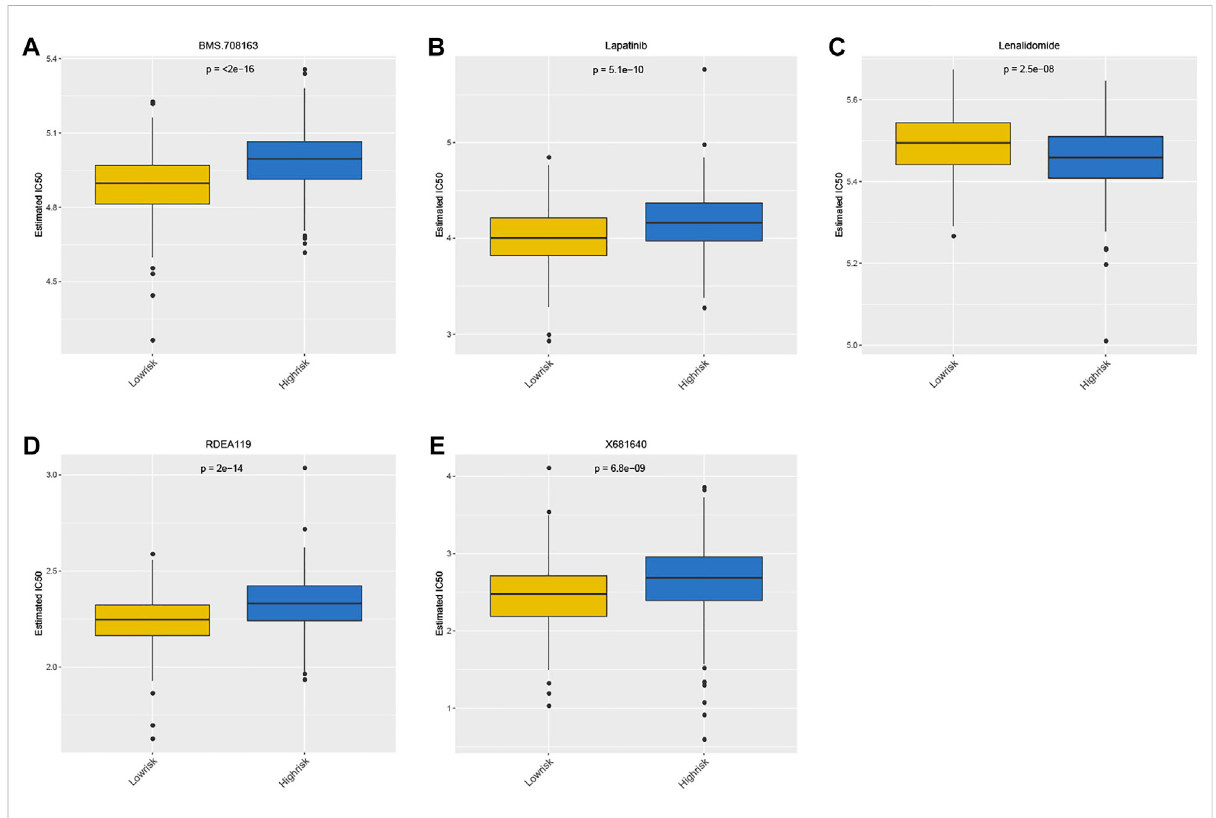
FIGURE 9 Drug sensitivity analysis between high- and low-risk groups based on